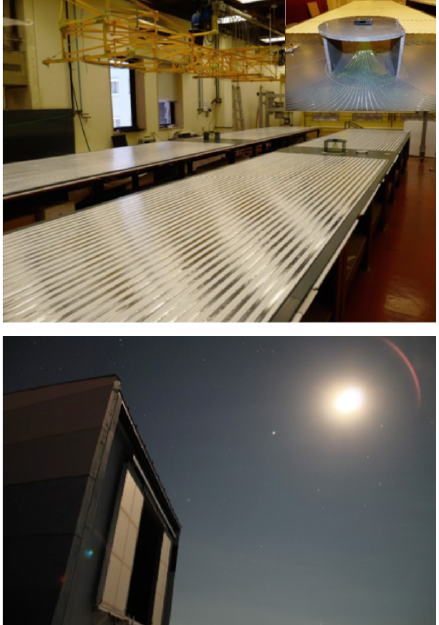
Figure 4. Top: Two AMIGA modules during assembly. Bottom: the Moon and Jupiter above one of the Fluorescence Detectors in the Pierre Auger Observatory.